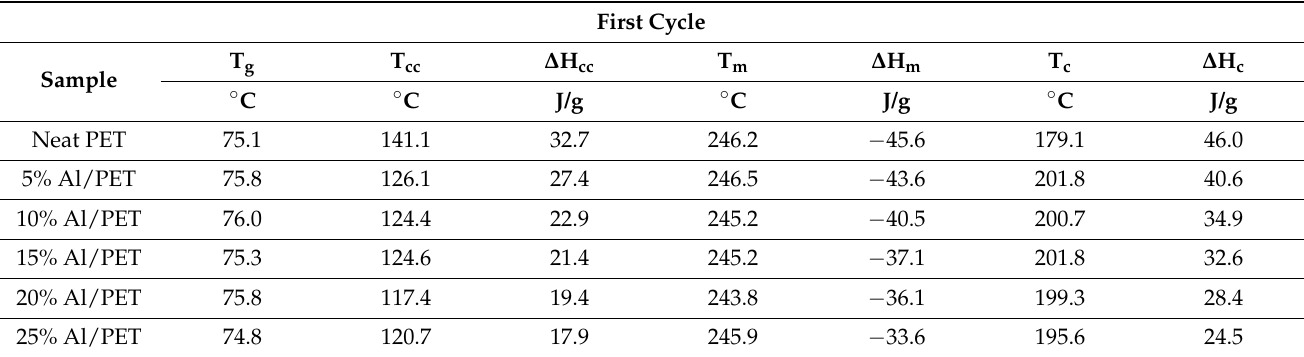
Table 3. Thermal parameters obtained from the first cycle of DSC thermographs (Figure 6) of neat amorphous PET and Al/amorphous PET